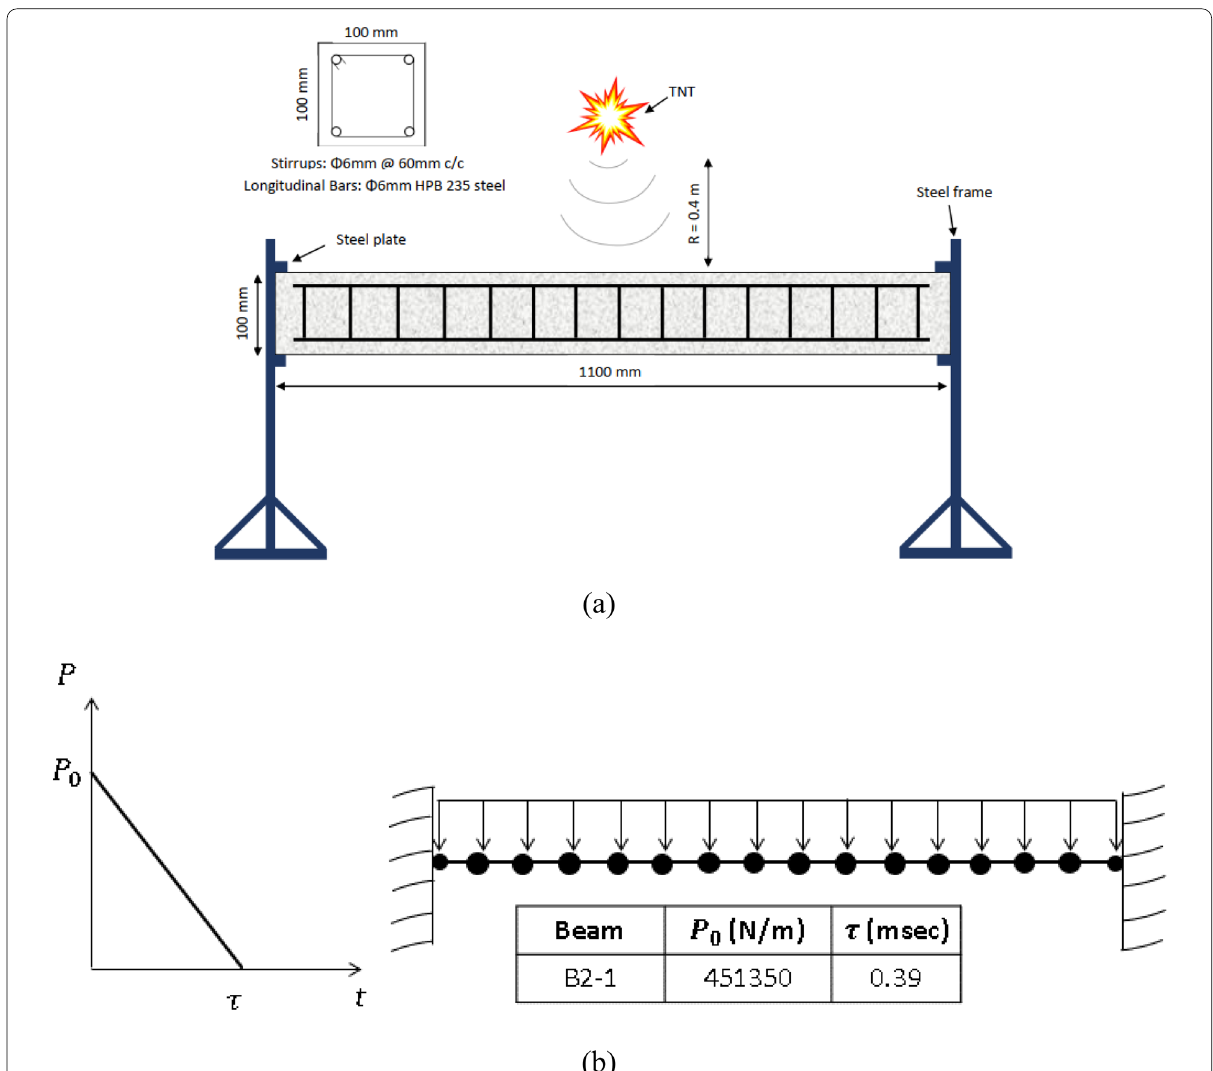
Fig. 25 RC beam under blast loading: a Zhang (Zhang et al., 2013) experimental setup, b LCP model of RC